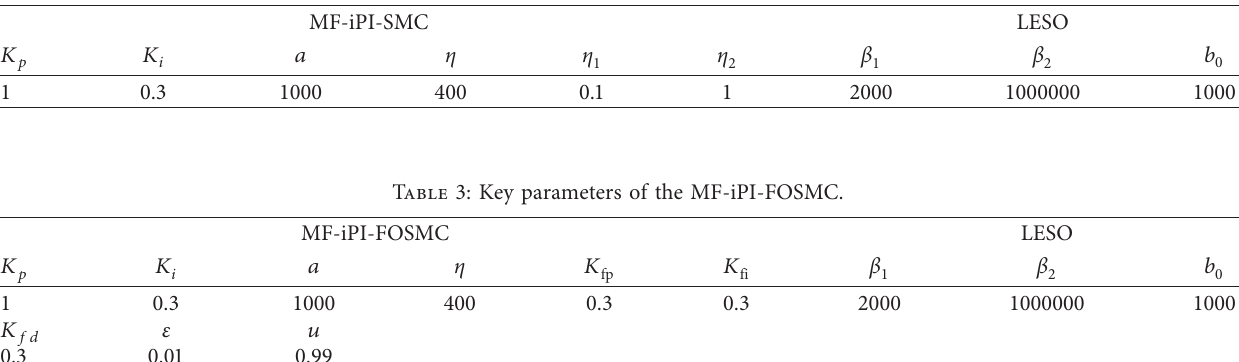
Table 2: Key parameters of the traditional MF-iPI-SMC.